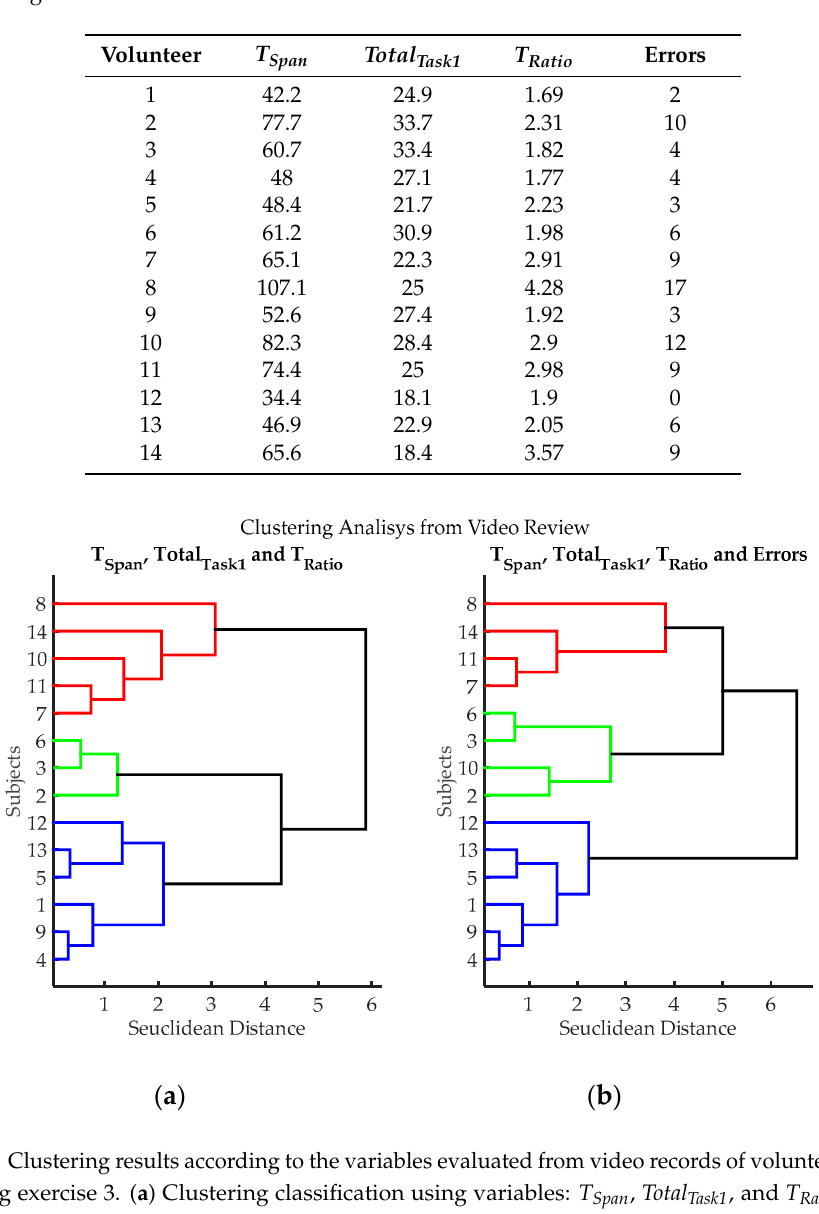
Table 1. Results for each of the volunteers obtained from the review of videos recorded during the third exercise. The Classification column shows resulting hierarchical classification from dendrograms shown in Figure 7.